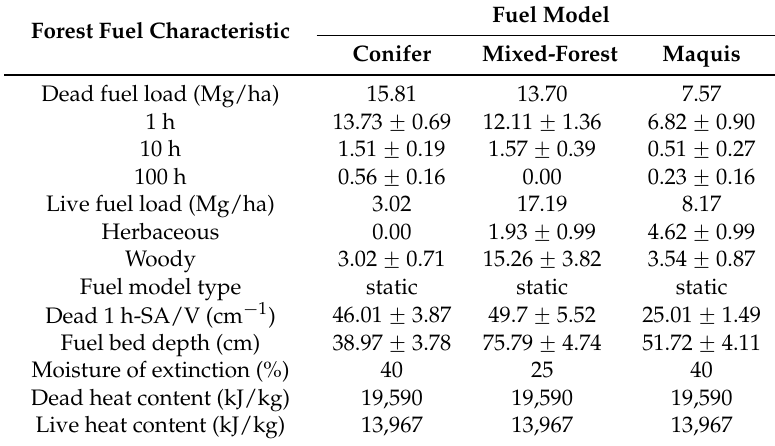
Table 1. Parameters ( ˘ SE) of the three customized fuel models derived from Elia et